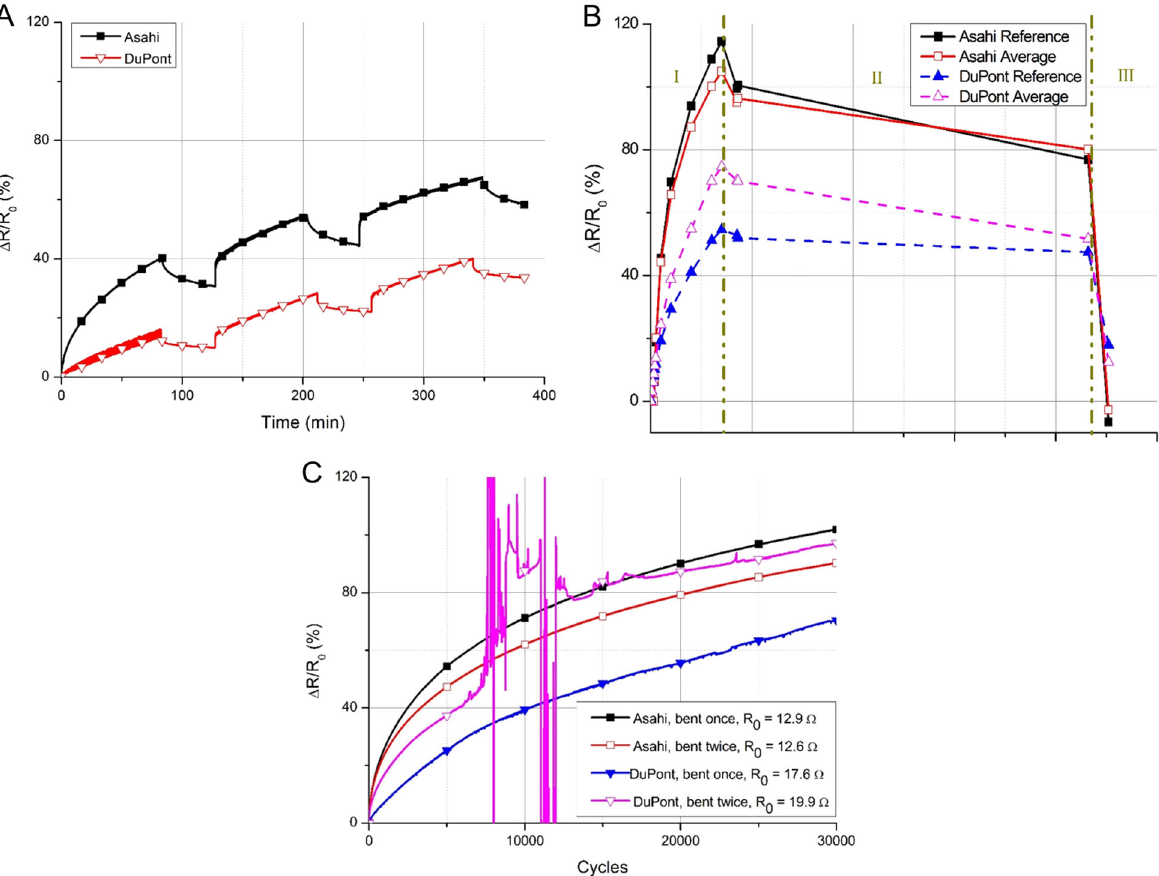
Fig. 5 Post annealing resistance recovery. a Cycle-rest-cycle measurement results. b Post anneal test results. I represents the cycling phase, II waiting phase and III post anneal phase. Inks ’ increased resistance with bending (I), stable elevated resistance (II), and “ healing ” with heat treatment (III) clearly visible. c Multiple bending cycle trials: bent samples test results with post annealed samples test results. “ bent once ” correlates with the fi rst bending cycle; “ bent twice ” refers to samples that have undergone two bending cycles.